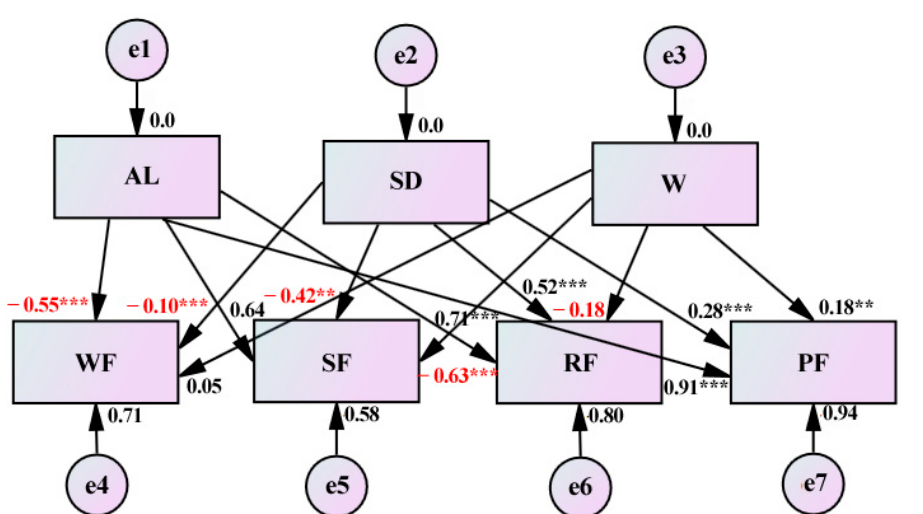
Figure 4. The coupling relationship model of the SSTFs and EFFIs. p = 0.40; RMSEA = 0.056;